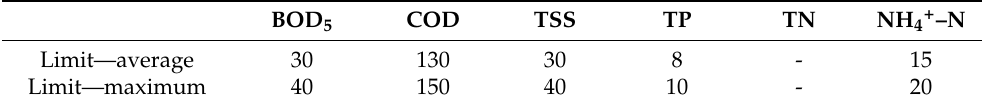
Table 2. Limit values in mg · L − 1 for the HCW in Kostelec nad Ohˇr í (given by legal permit in accordance with Czech law).